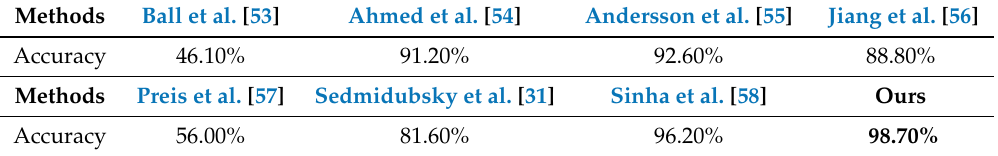
Figure 4. Skeletal structures: left : the CMU Mocap database, middle : the UPCVgait database, and right : our database. Table 1. Recognition rate of all individual recognition methods tested with the CMU Mocap database.